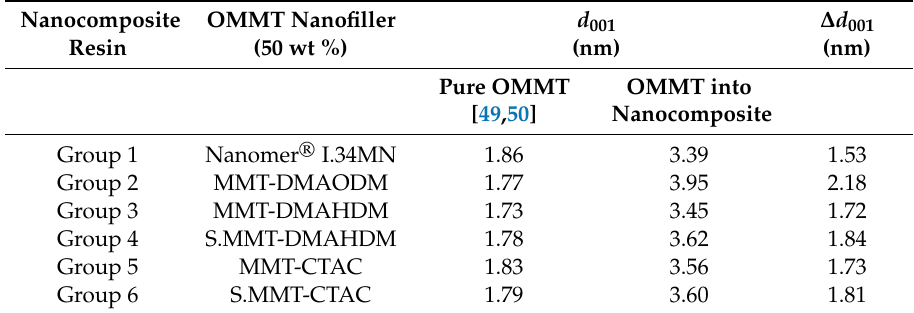
Table 1. d 001 -spacing values calculated on the basis of X-ray di ff raction (XRD) spectra for di ff erent species of nanoclays incorporated in nanocomposite